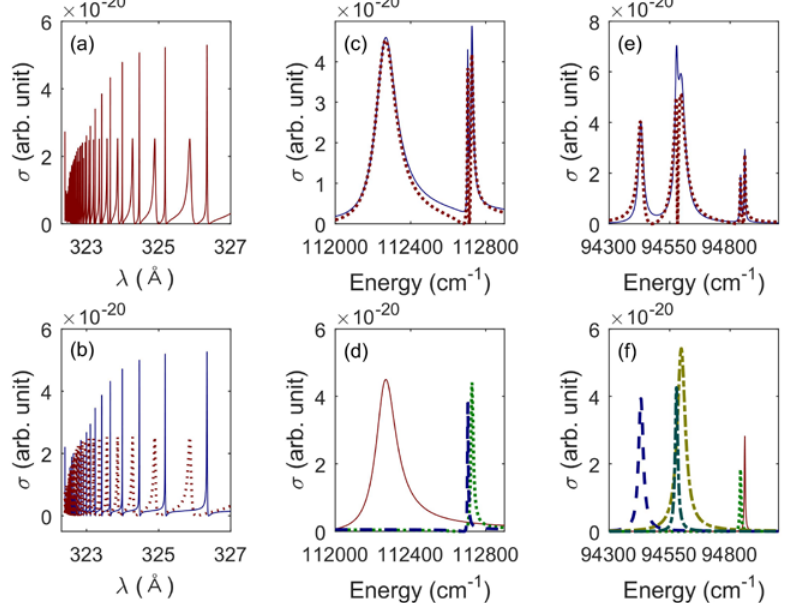
Figure 11. The decomposition of the autoionizing spectra ( a ), ( c ), and ( e ) into the incoherent sum of isolated resonance spectra ( b ), ( d ) and ( f ), respectively. The sum of isolated spectra are drawn with solid lines and the exact σ with dotted lines in ( a ), ( c ) and ( e ). The differences are the cross terms. Isolated spectra are ns and nd series of Na in ( b ), np 3/2 , nf 1/2 , and nf 3/2 series of Hg in ( d ), np [2] 3/2 , np [1] 1/2 , np [1] 3/2 , nf [1] 1/2.3/2 , and nf [2] 3/2 of Ag in ( f ). See the text for the description of the systems in Na, Hg and Ag (from [27]).